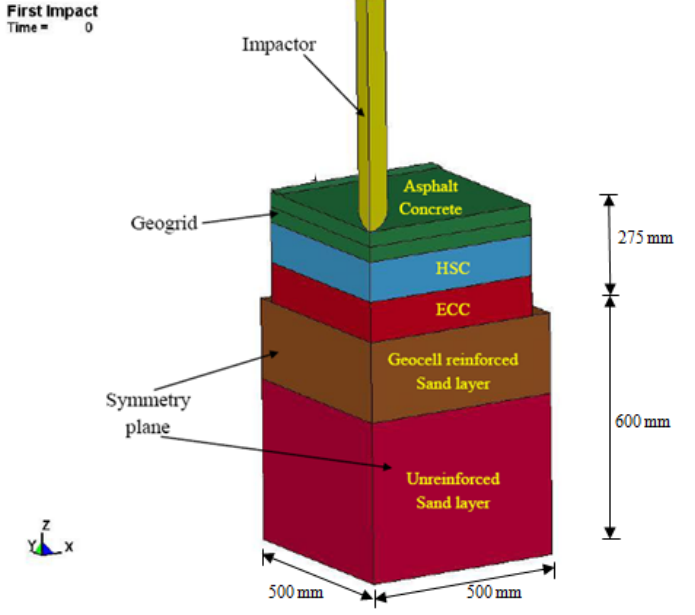
Figure 15. Configuration of the drop weight head (quarter model): ( a ) standard configuration; ( b ) simple configuration. Table 11. Properties of the drop weight head.